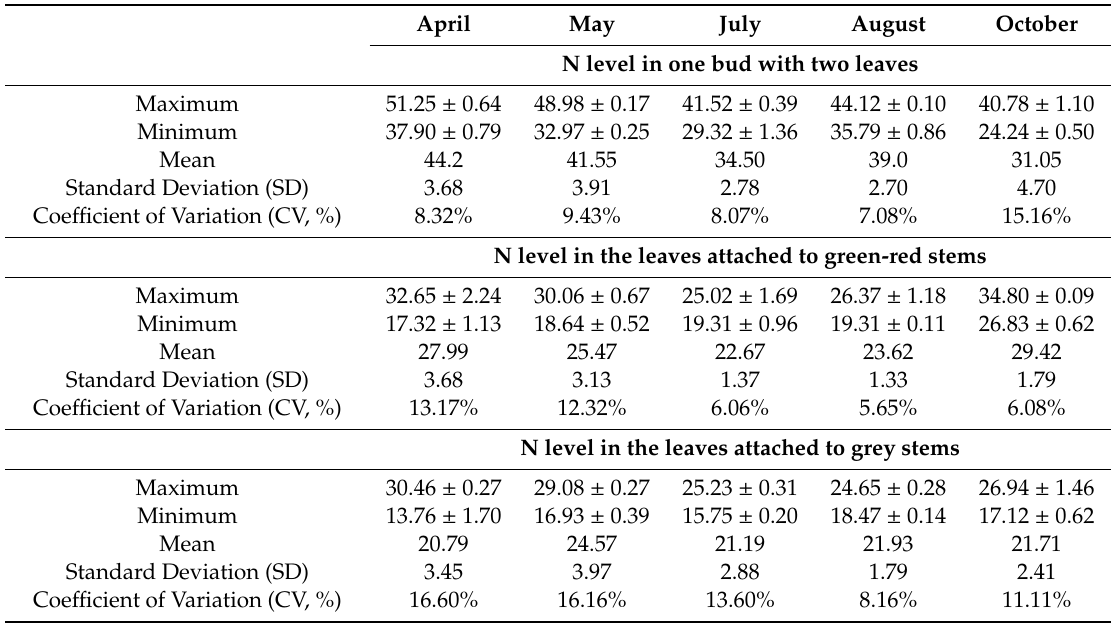
Table 1. Summary for N levels (g kg − 1 ) in the three categories of leaves for the twenty tea varieties over the entire growing